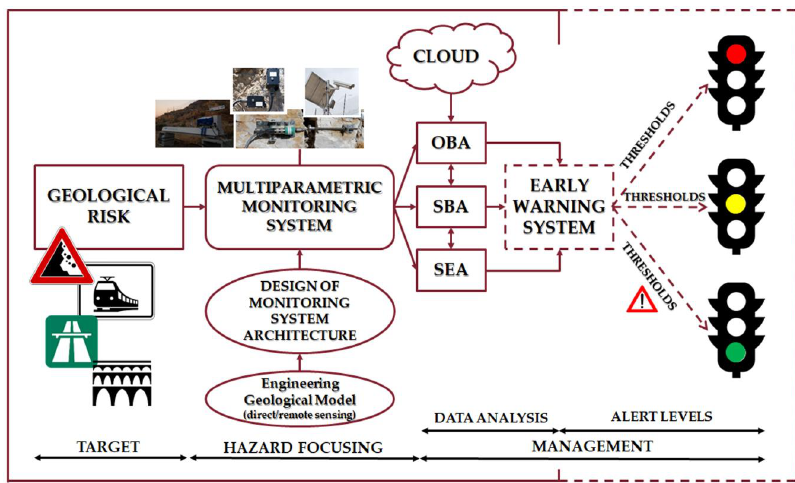
Figure 3. Flow chart showing the role of data management approaches in the frame of geological risk mitigation activities. The data from a multi-parametric monitoring system are processed through the proposed approaches for mitigation of the geological risk by a real-time early warning system. The continuous-line box indicates the themes and activities carried out in the frame of this research. The dashed-line box indicates the future calibration of an early warning system based on the results of the compared approaches (modified from Bozzano et al. [72]).